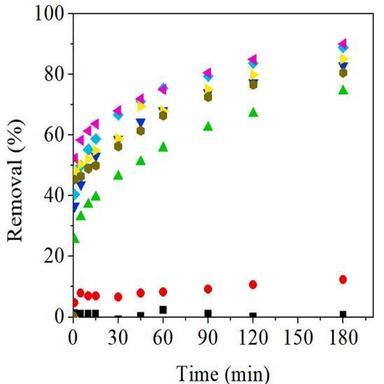
Results of the experiments studying the doseFe effect on the removal of DR80 from solution by the EG-nZVI. doseFe = ■ 0 mg L− 1 ; 0.2 mg L− 1 ; 0.8 mg L− 1 ; 1.4 mg L− 1 ; 2 mg L− 1 ; 5 mg L− 1 ; 8 mg L− 1 10 mg L− 1 . Other reaction conditions: doseH202 = 1.5 mmol L− 1 and pH0 = 5.5.